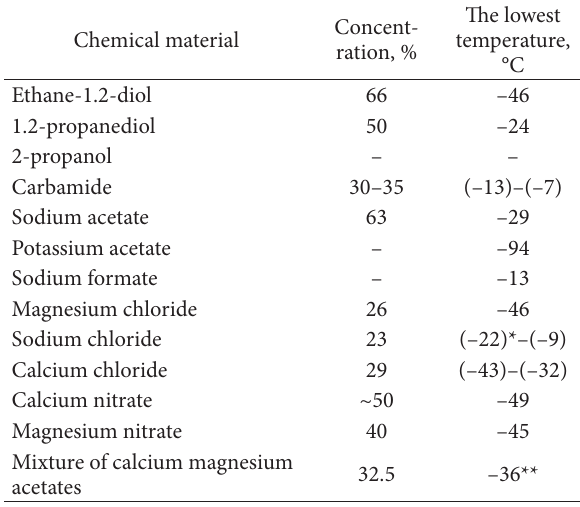
Table 2. Chemical materials able to lower the freezing temperature of water solutions if eutectic points are